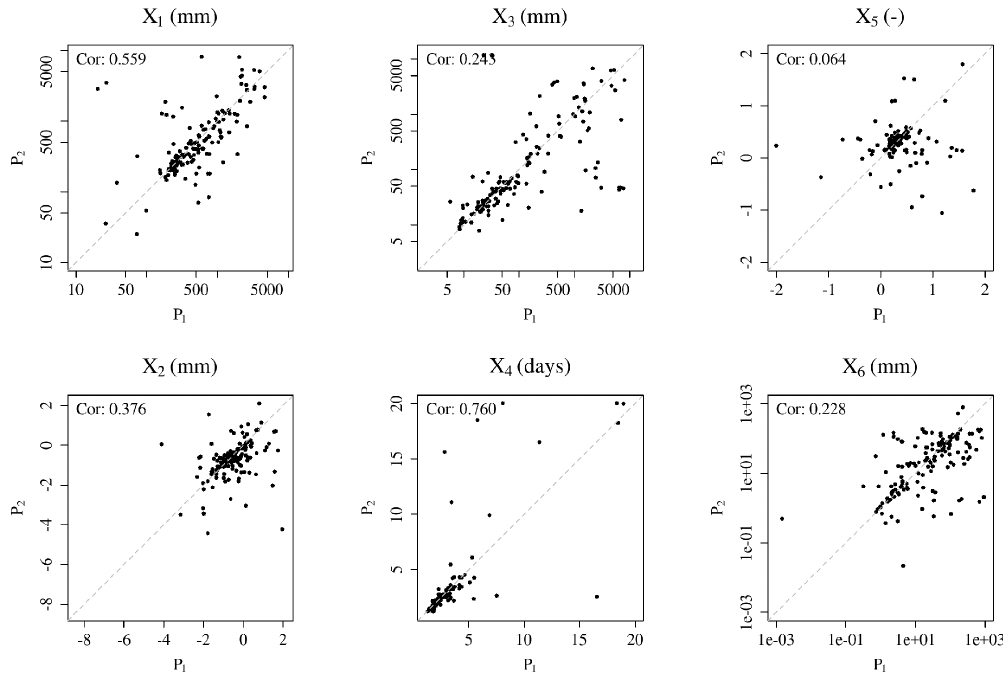
Figure 14. Comparison of the values obtained for the six model parameters through calibration on the two periods of the split-sample test using the original calibration framework with α = 0. Log scales are used for visual readability in some plots. The Pearson correlation between periods is indicated.